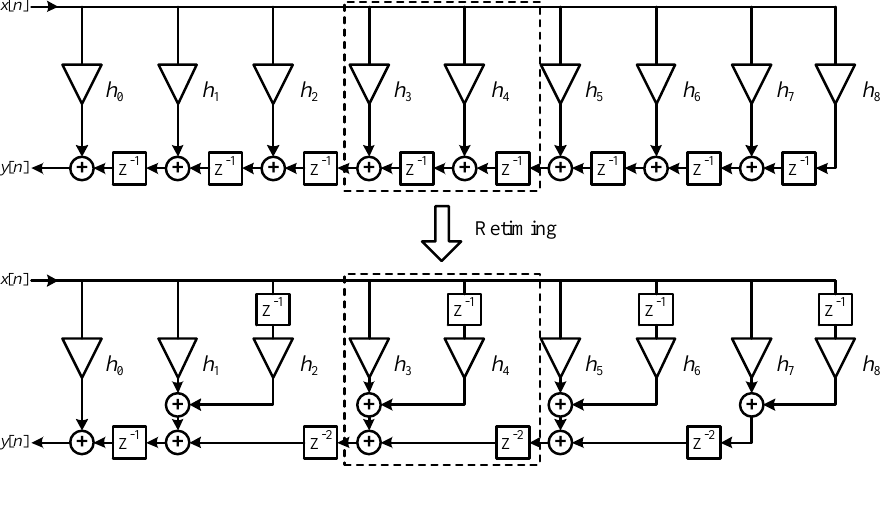
Figure 2. The structure for L =